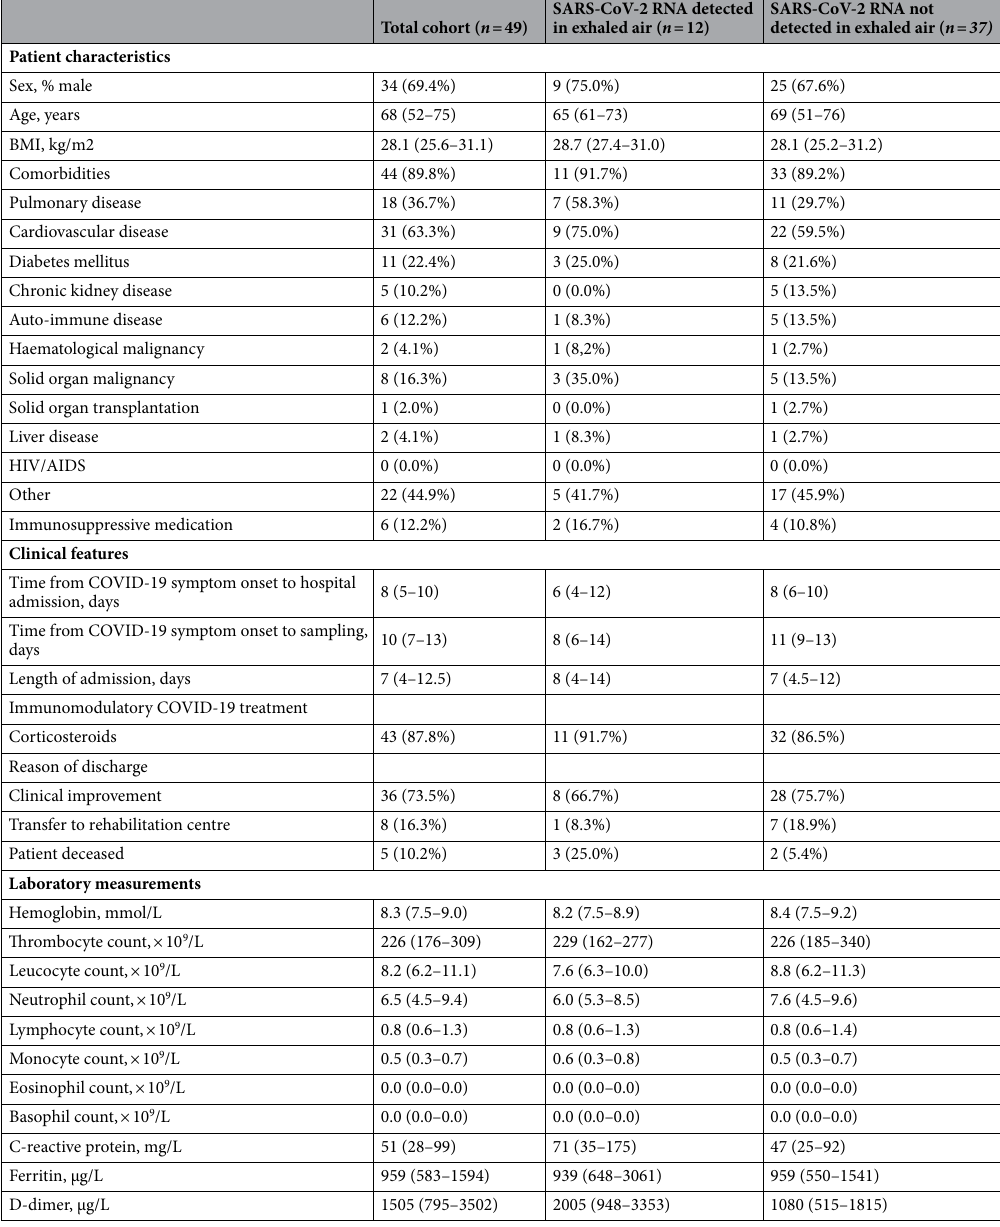
Table 1. Patient characteristics, clinical features and laboratory measurements. Nominal data are presented as numbers with percentages, and continuous data are presented as medians with interquartile ranges. No significant differences were